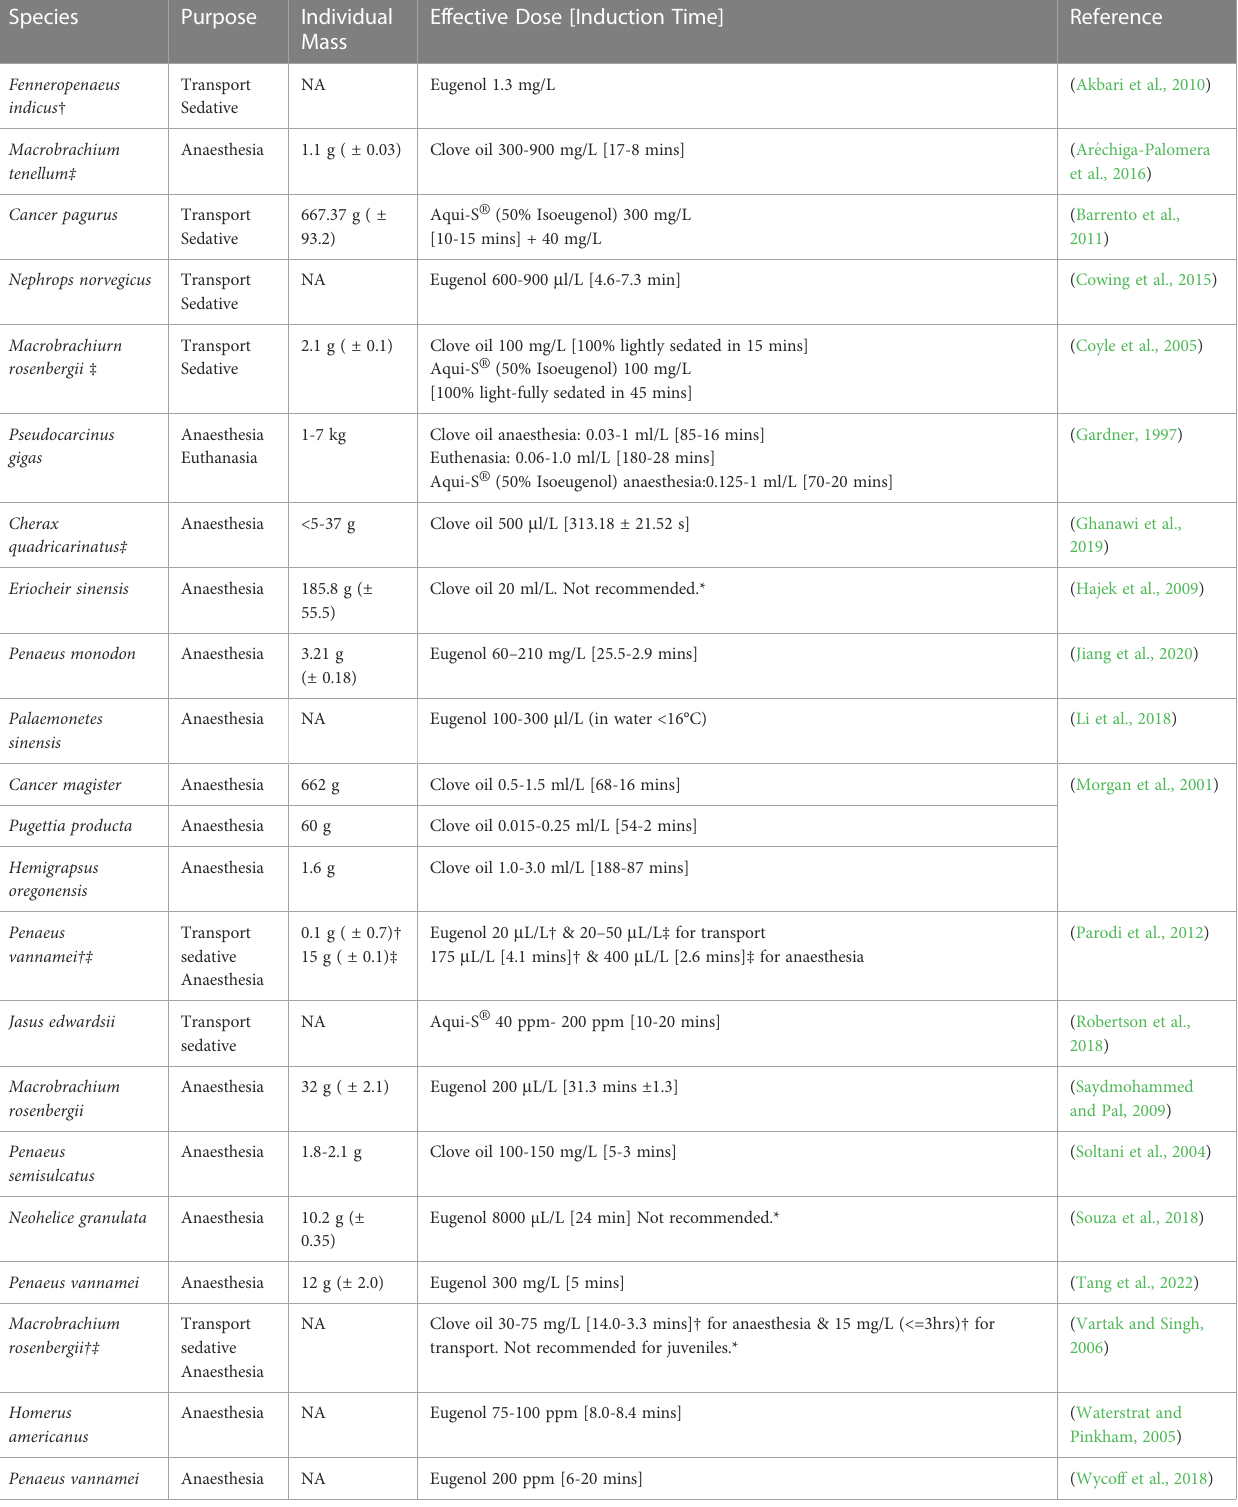
TABLE 1 Existing, accessible literature arranged alphabetically by fi rst author, concerning the use of clove oil, eugenol and isoeugenol via anaesthetic bath on decapod crustaceans for the purpose of transport, anaesthesia and